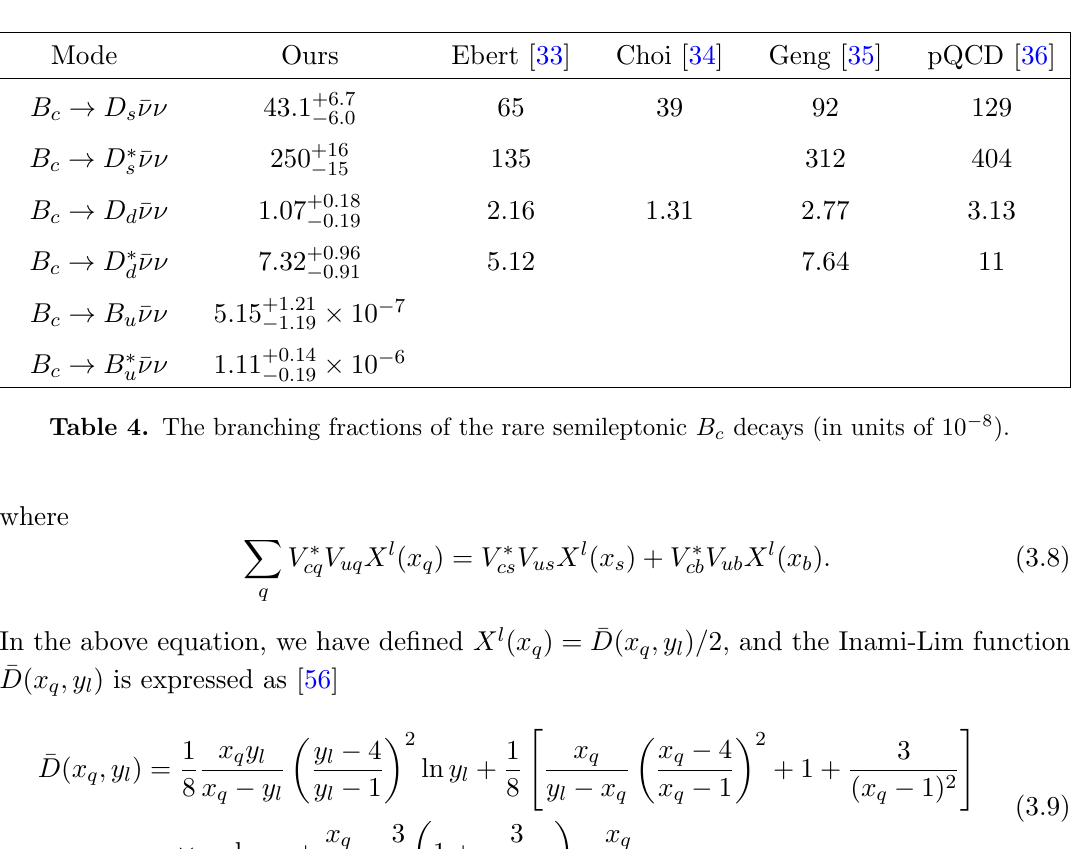
B ( (cid:3) ) (cid:0) (cid:23) (cid:22) (cid:23) . c !